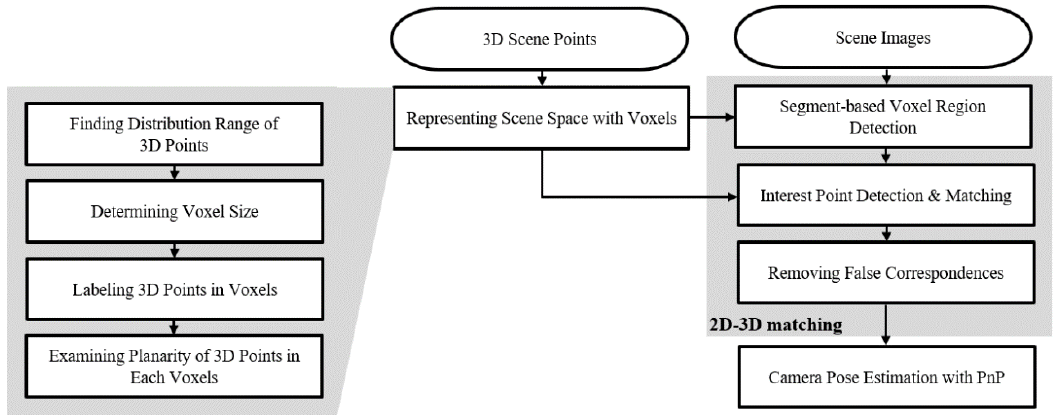
Figure 1. Flow chart of the proposed method.